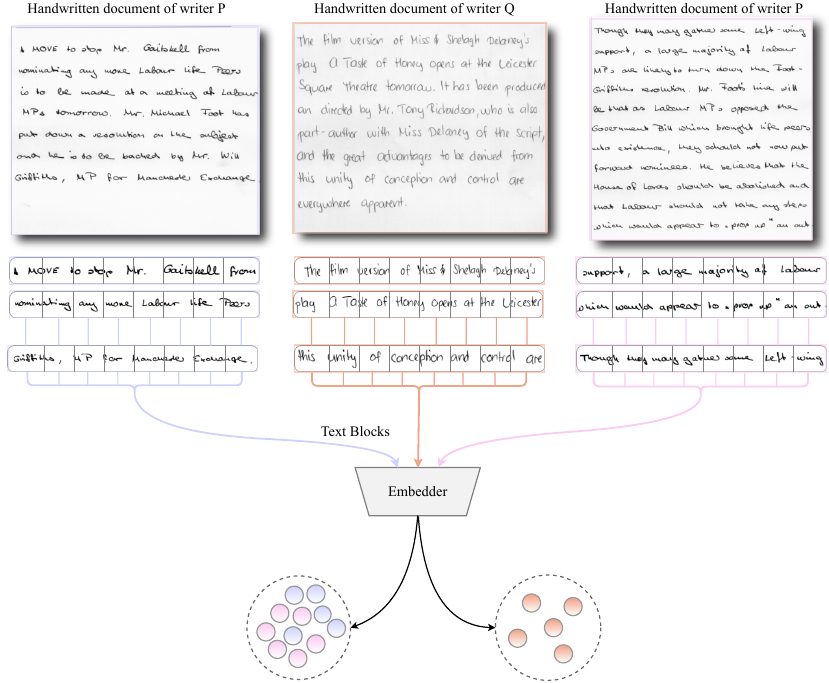
Figure 1. The figure demonstrates a set of handwritten documents with an unknown number of writers (in the example, two writers, p and q). Handwritten documents are segmented into a form of line, and further line-segmented images are windowed into smaller image frames, considering that all the frames of a single document belong to a single class. A DL-based embedding method also identifies feature similarities and relationships in handwritten documents. Clusterable embeddings are generated as a result of the